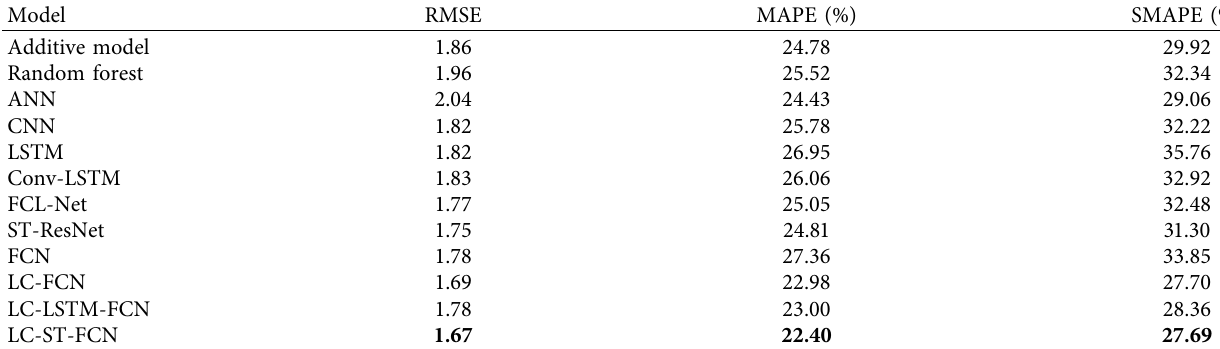
Table 1: Comparison of the predictive